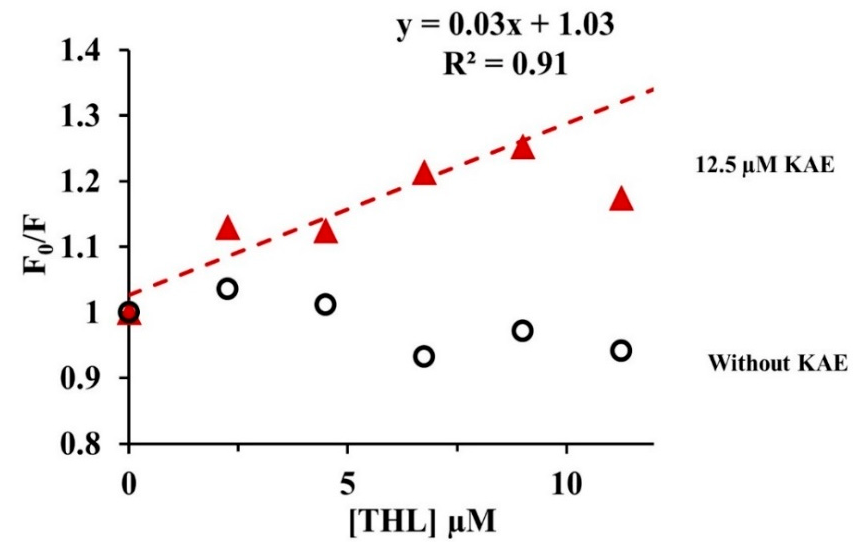
Figure 6. Stern–Volmer plots (F 0 /F) for quenhing of CpLIP2 lipase fluorescence as a function of THL concentration in the presence and absence of 12.5 µM KAE. CpLIP2 added at 2.5 µM and inhibited by THL concentrations: 0, 2.25, 4.5, 6.75, 9, 11.25 µM through pre-incubation period for 30 min at 25 °C, with 50 mM sodium phosphate buffer (pH 7.0), 300 mM NaCl and EtOH 0.01%. The fluorescence emission intensity was recorded at ʎ ex = 285 nm and ʎ em = 350 nm. Values represent the mean of three replicates . Correction of inner filter was applied systematically.